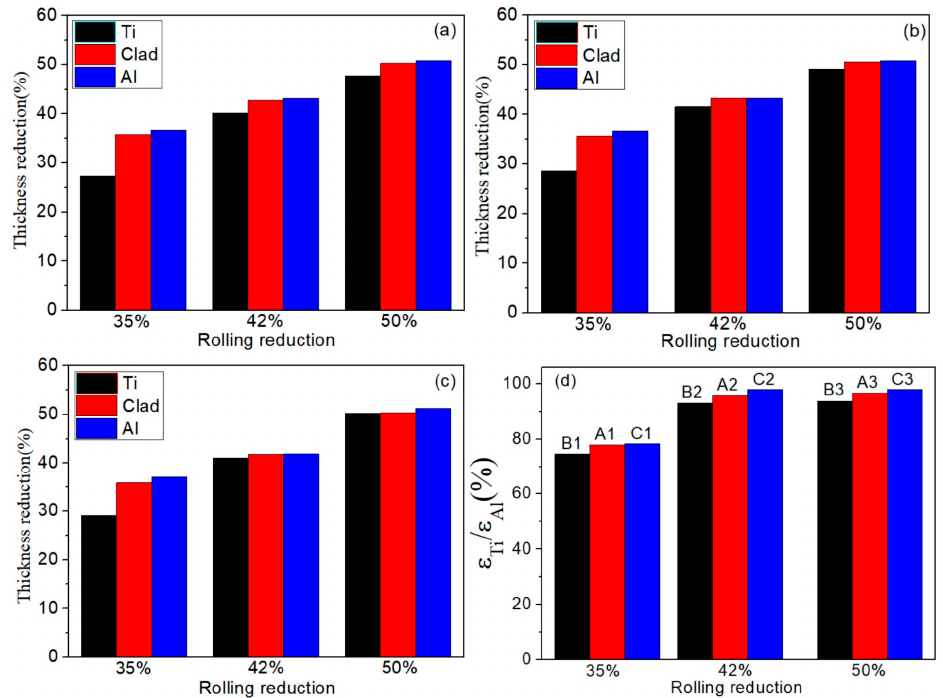
Figure 5. Deformation of each layer of three types of Ti/Al composite sheets under different rolling reductions. ( a ) Specimen B; ( b ) specimen A; ( c ) specimen C; ( d ) variation of deformation ratio of titanium and aluminium with total rolling reduction.